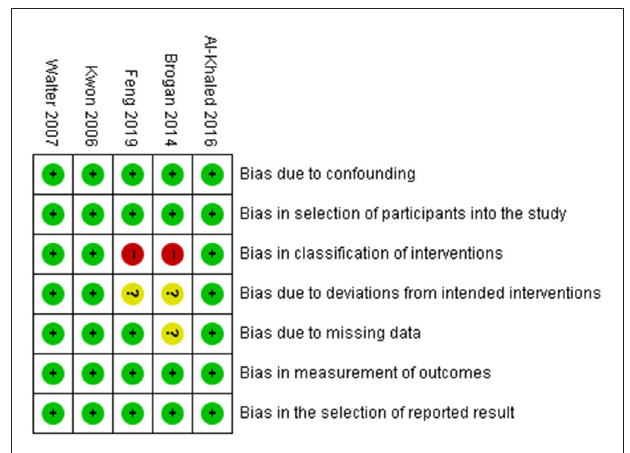
FIGURE 2 | Risk of bias summary.